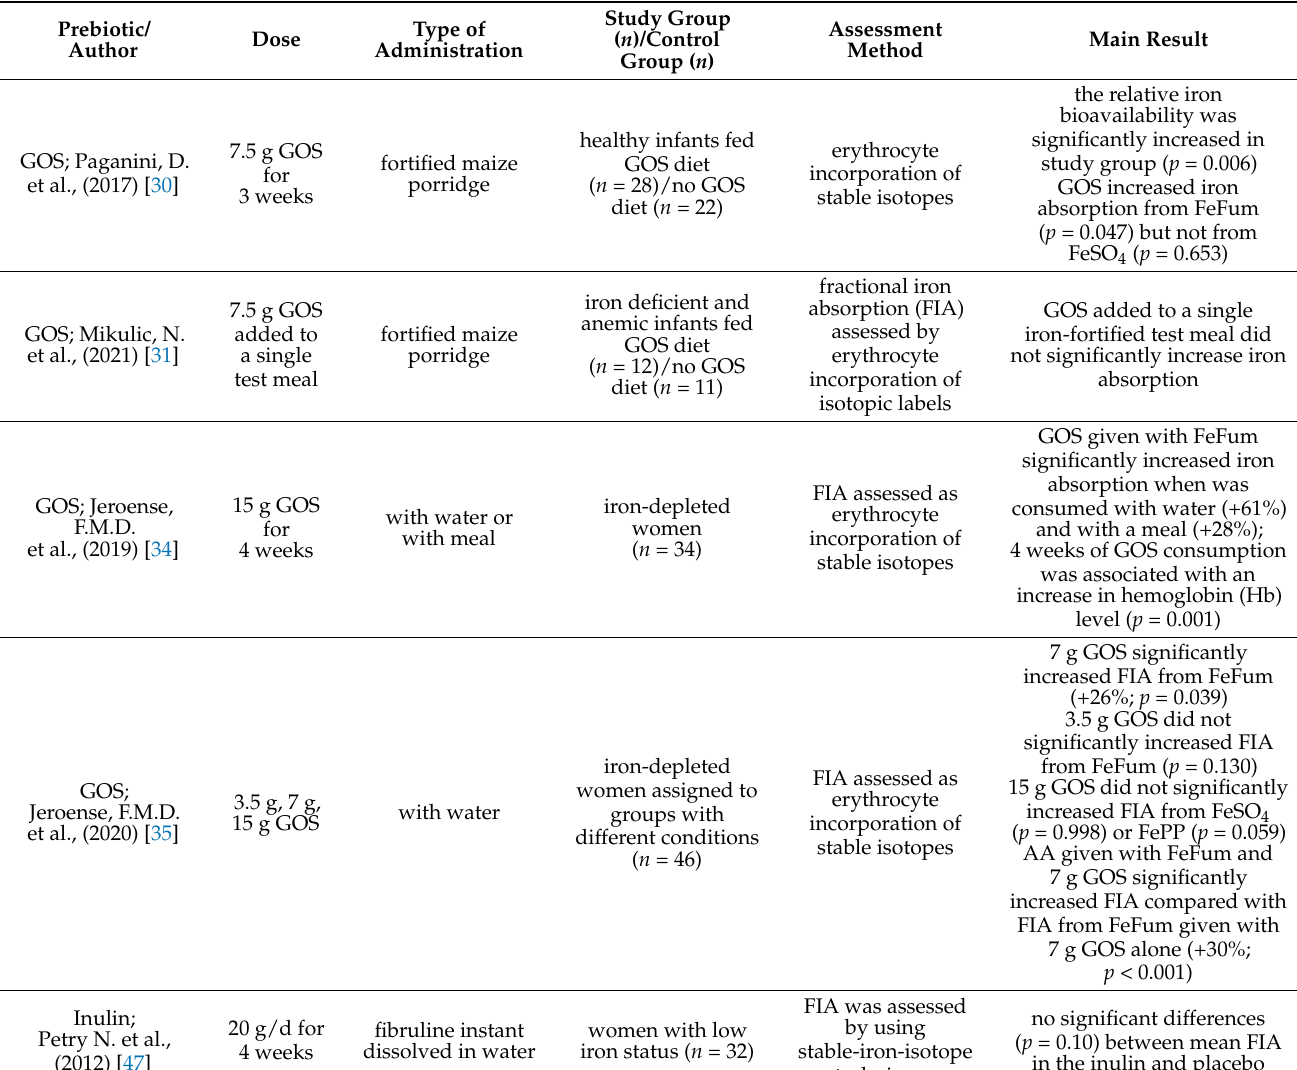
Table 1. Summary of human studies on prebiotics in